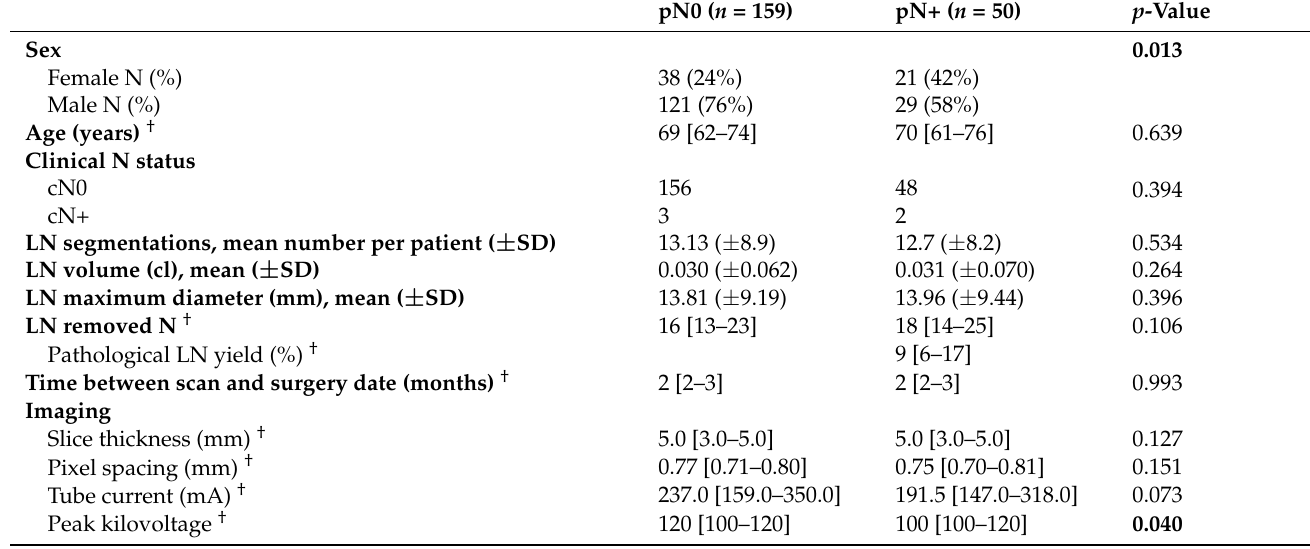
Table 1. Patient characteristics of the subset of 209 patients from the CirGuidance trial [33] used in the current post hoc analysis. Statistically significant p -values are depicted in bold